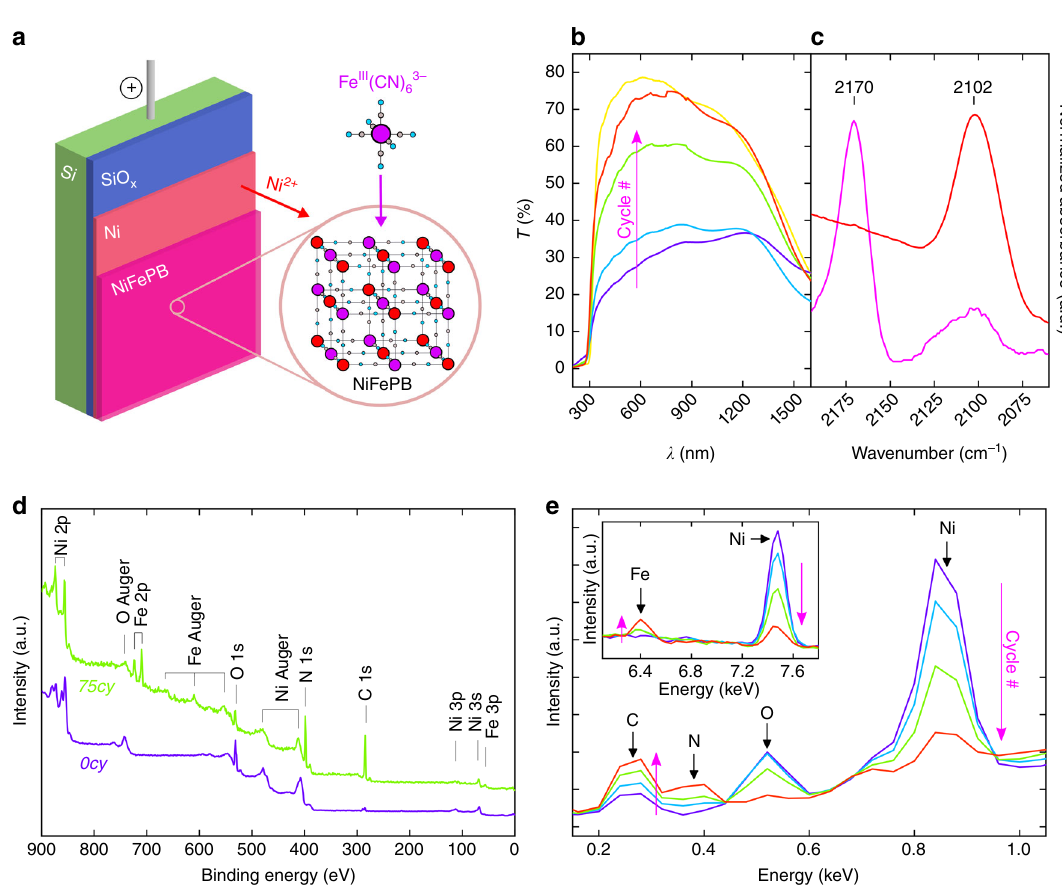
Fig. 1 Physicochemical characterization of the Ni/NiFePB layers. a Scheme showing the method employed for manufacturing the Si/SiO x /Ni/NiFePB surfaces. b Transmittance spectra of FTO/Ni/NiFePB surfaces obtained with different number of cycles ((purple) 0cy , (light blue) 25cy , (light green) 75cy , (red) 150cy , (yellow) bare FTO). c ATR-FTIR spectra of a p + -Si/SiO x /Ni/NiFePB surface (pink) after preparation and (red) after cathodic polarization in 1 M KCl. d XPS survey spectra recorded for (purple) p + -Si/SiO x /Ni/NiFePB- 0cy and (light green) p + -Si/SiO x /Ni/NiFePB- 75cy . e EDS spectra of p + -Si/SiO x / Ni/NiFePB obtained with different number of cycles (purple) 0cy , (light blue) 25cy , (light green) 75cy , and (red) 150cy